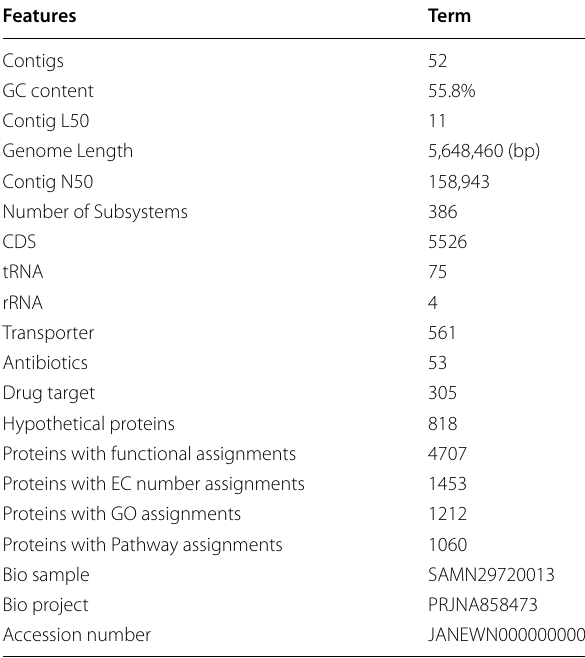
Table 2 Genomic features of R. planticola FACU 3 genome Features